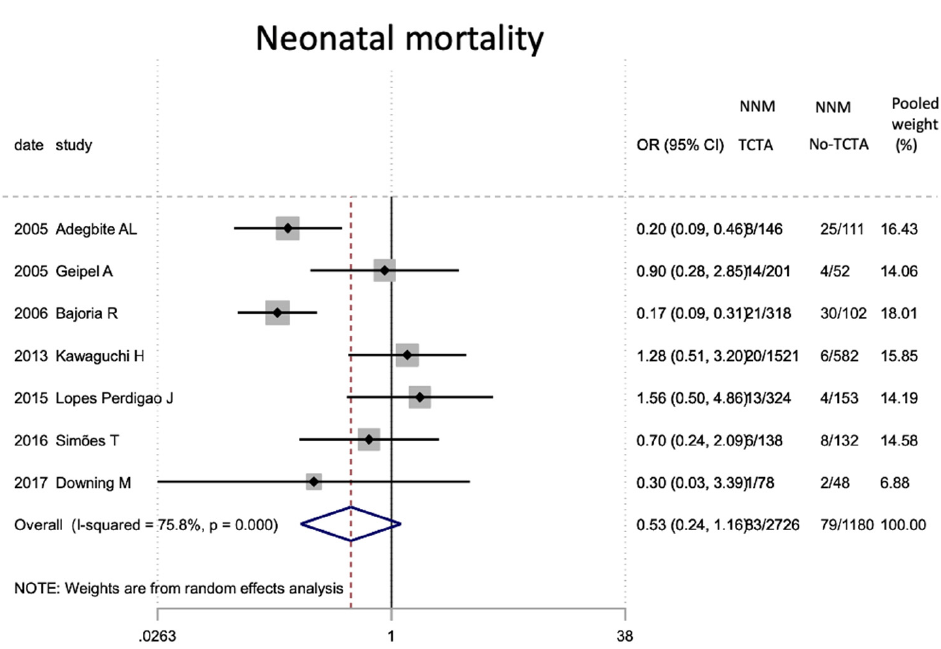
Figure 15. Results of the meta-analysis on the effect of chorionicity (TCTA vs no TCTA) on intrauterine fetal mortality. MFIU: intrau-terine fetal mortality; TCTA: trichorial-triamniotic, non- TCTA: non-trichorial-triamniotic. OR = odds ratio, CI = confidence interval.